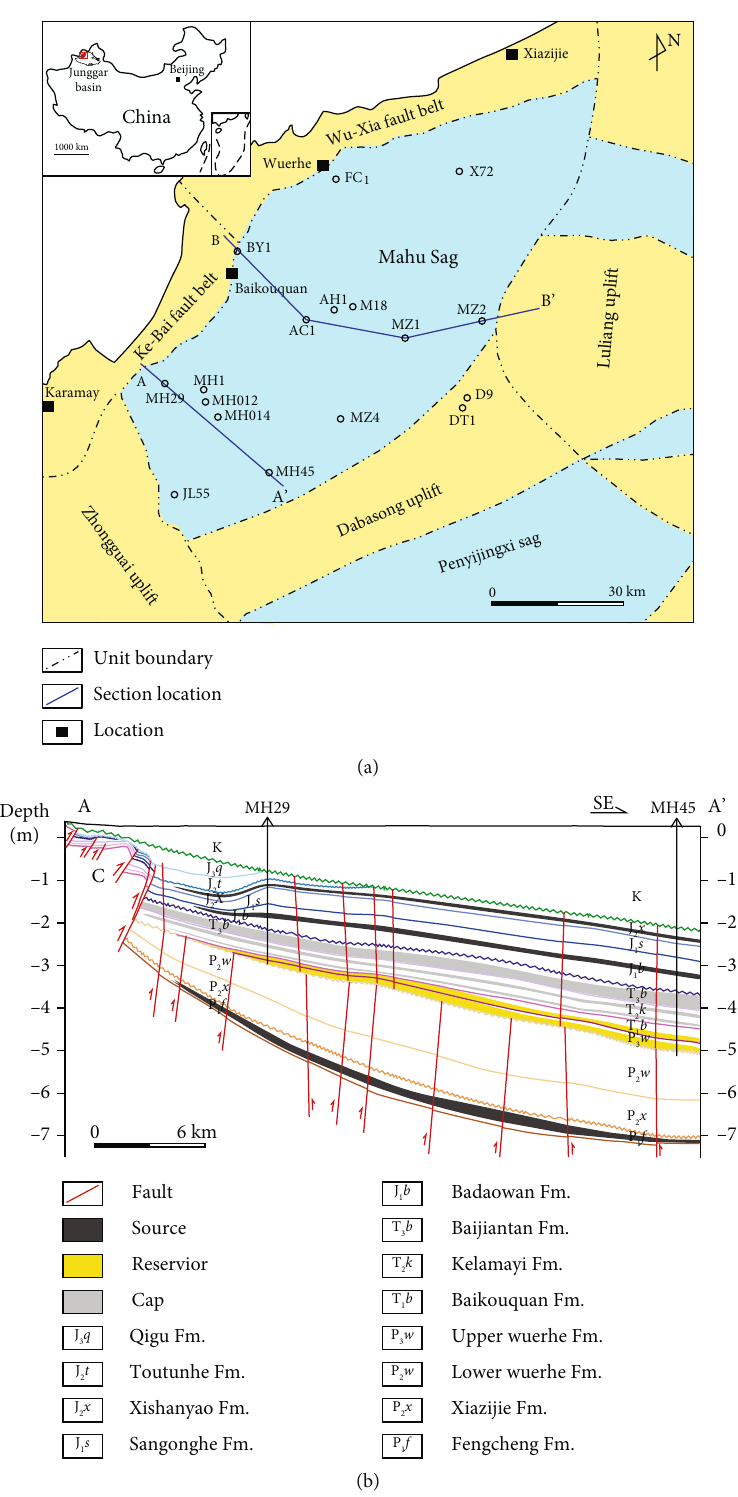
Figure 1: (a) Tectonic units and (b) a geological structure pro fi le of the Mahu